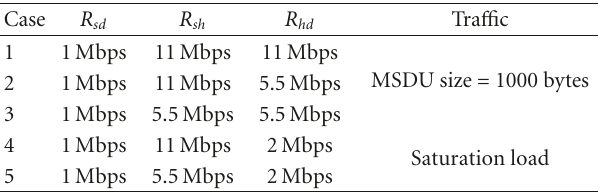
Table 4: Settings for baseline